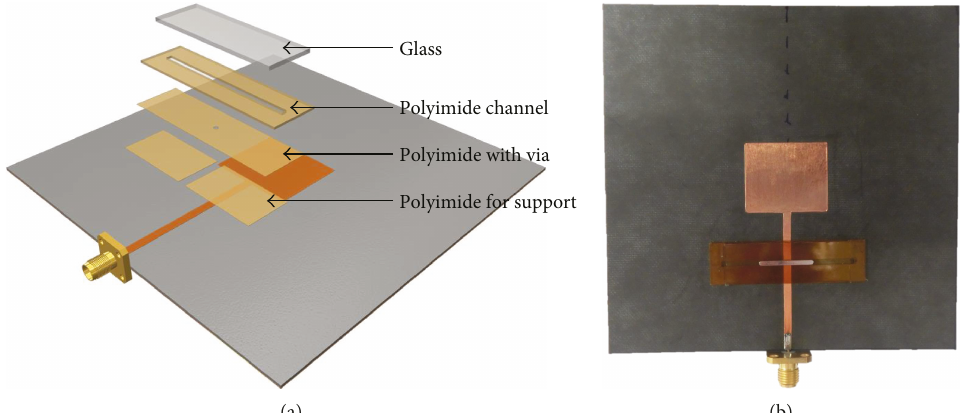
Figure 5: Liquid-metal gain-recon fi gurable antenna: (a) exploded view; (b) fabricated prototype.